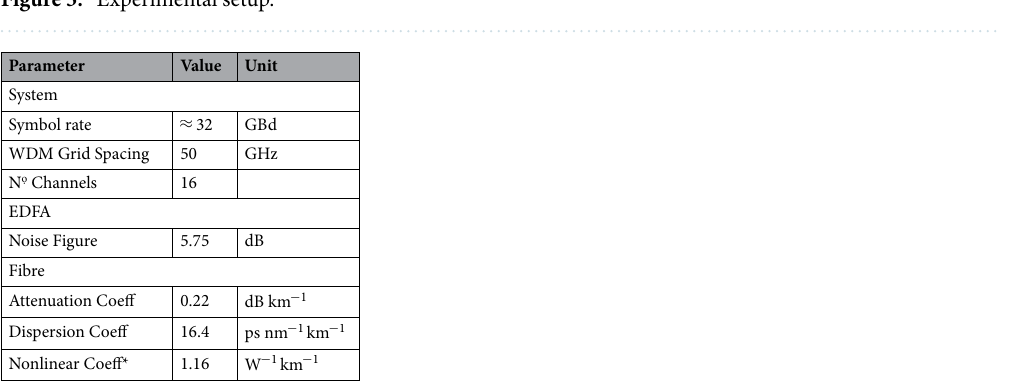
Table 5. System design and component parameters. These values were assumed to apply across all 16 channels, 1550 ± 4 nm. *Effective nonlinear coefficient for launch power at switch monitor before any patch panel connector